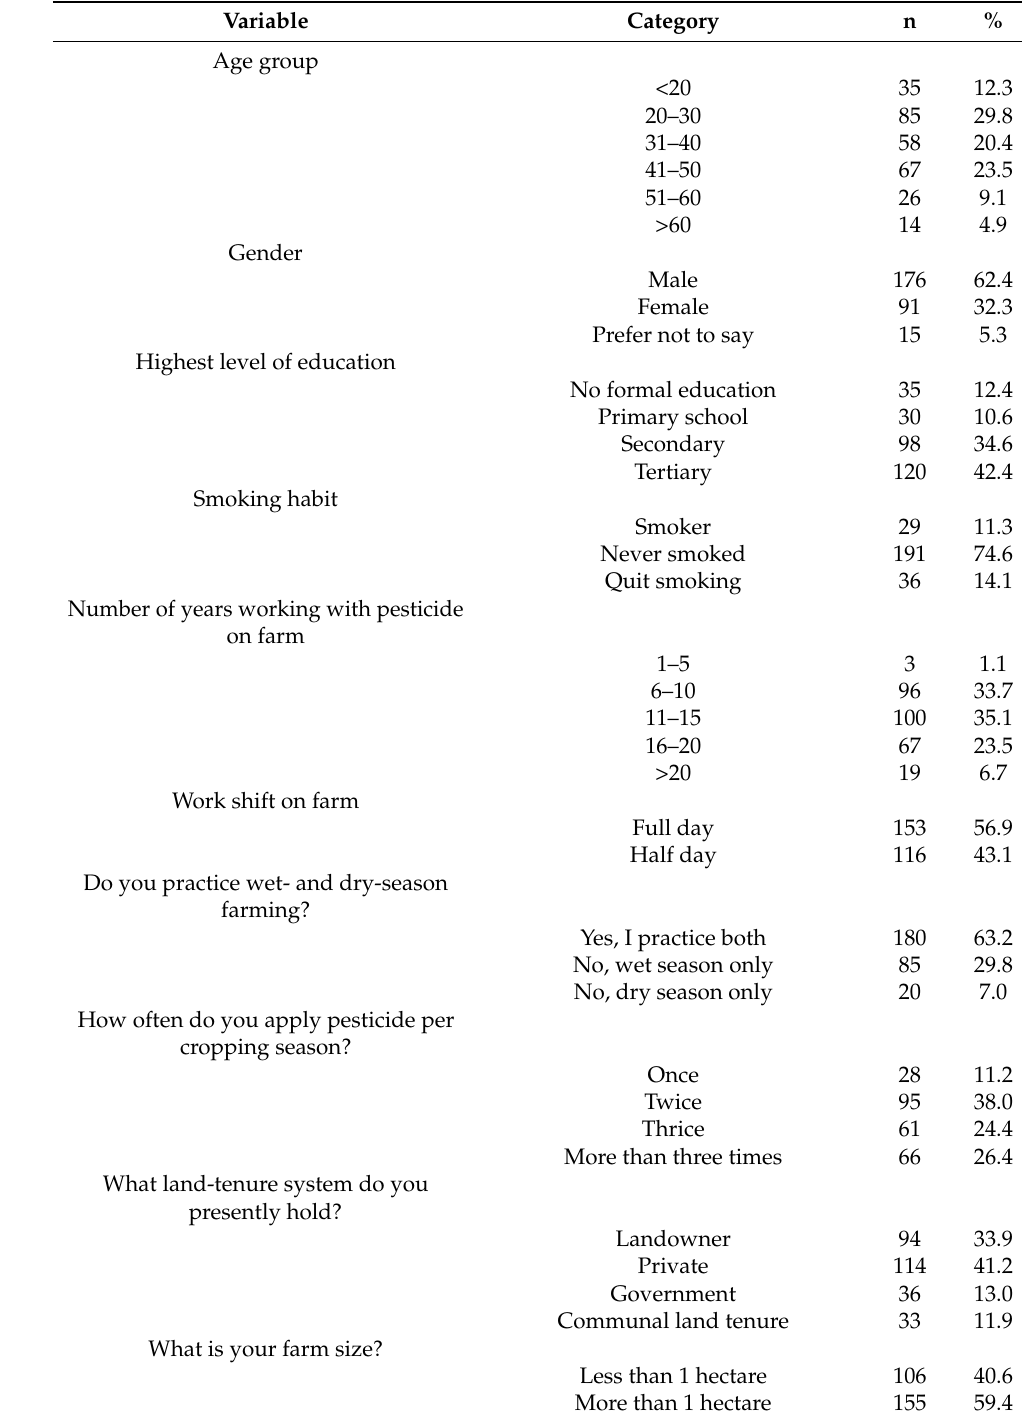
Table 2. Sociodemographic Characteristics of the Study Population.